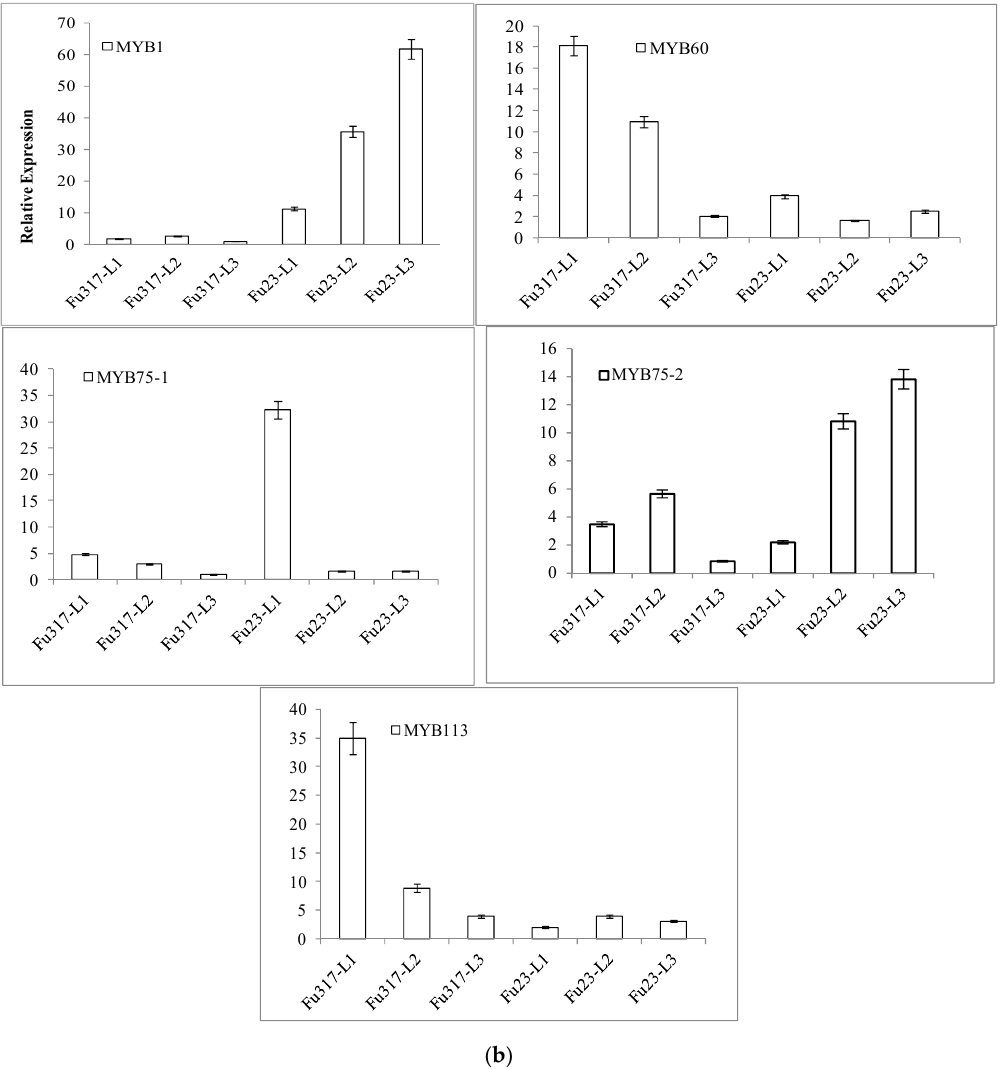
Figure 3. Expression of anthocyanin structural genes and transcription factors in the purple sweet potato cultivars Fushu No. 23 and Fushu No. 317. ( a ) Simplified model of the anthocyanin biosynthetic pathway and qRT-PCR analysis of the transcript abundance of the anthocyanin biosynthesis-related genes in Fushu No. 23 and Fushu No. 317 leaves. ( b ) Expression of transcription factors IbMYB s in sweet potato leaves.